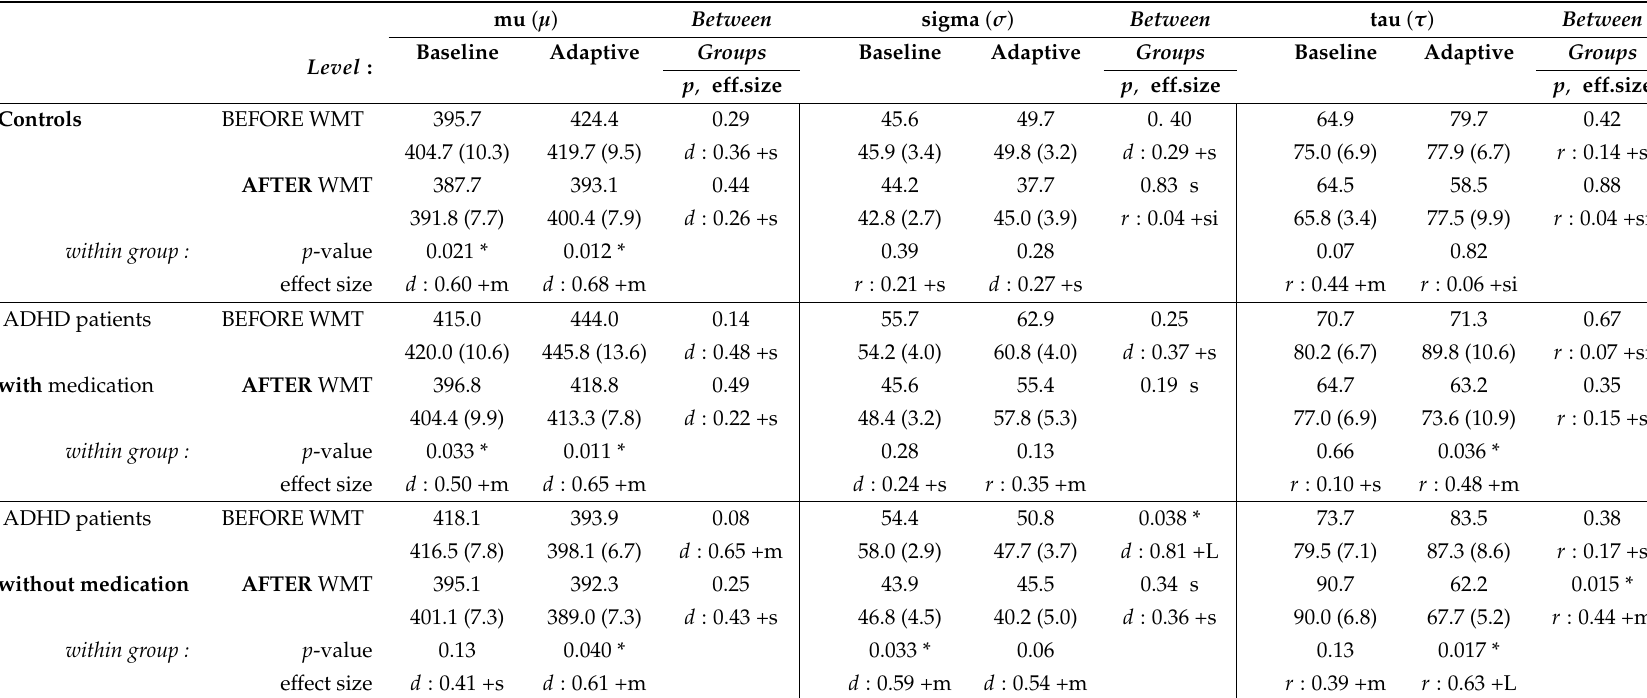
Table 5. Descriptive statistics (median, mean, and SEM) of ex-Gaussian parameters ( mu , sigma , tau ) for each group of participants. Comparisons between levels of training and between before- and after-training within each group are reported with the corresponding p -values and effect sizes Cohen’s d or non-parametric r computed following the outcome of the normality